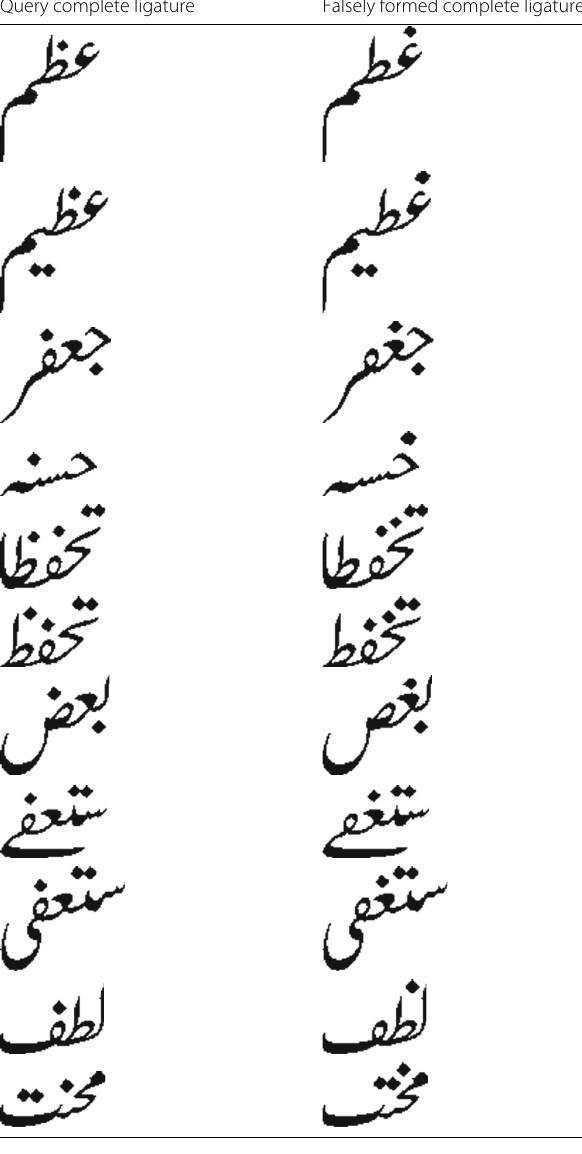
Table 12 Examples of incorrectly postprocessed complete ligatures (after correct recognition of primary and secondary ligatures) due to incorrect re-association Query complete